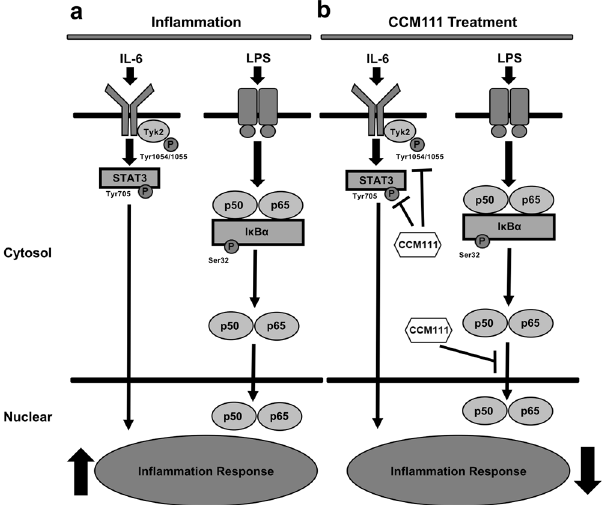
Figure 8. The model of effects of CCM111 in macrophage cells. ( a ) LPS induces the activation of the TLR4/ NF- κ B pathway and up-regulates IL-6 to activate the STAT3 pathway. The activation of the STAT3 and NF- κ B pathways results in the enhancement of inflammatory responses. ( b ) CCM111 significantly suppresses the STAT3 pathway through inhibiting the phosphorylation of STAT3 and Tyk2, and it suppresses the NF- κ B pathway by inhibiting the nuclear translocation of p65 to repress LPS-induced inflammatory